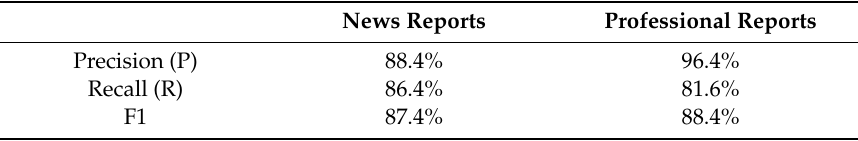
Table 6. Evaluation results of earthquake